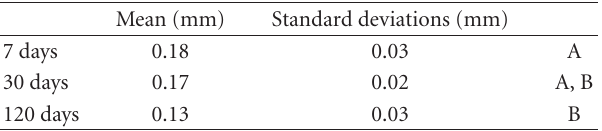
Table 1: Mean of the values of the reabsorption of the BC- HA membranes and standard deviations (di ff erent letters indicate statistical di ff erence among periods according Turkey’s test ( P < 0 .